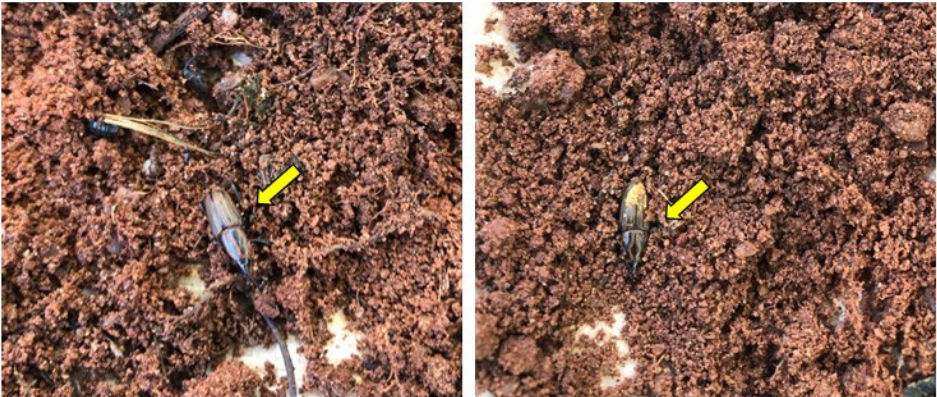
Figure 11. Sphenophorus levis adults found freely on soil and not attached to sugarcane rhizomes and roots as indicated by yellow arrows.